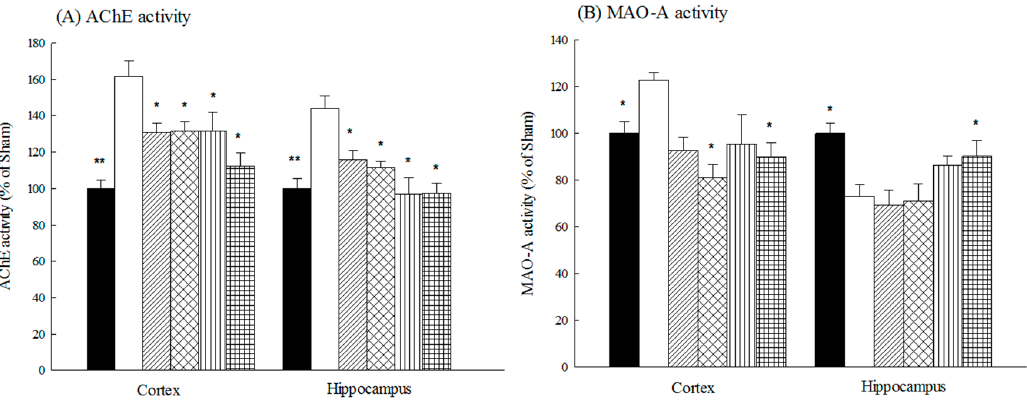
Figure 5. Effects of acteoside or isoacteoside (2.5, 5.0 mg/kg; po) on: ( A ) choline (Ch) levels; ( B ) acetylcholine (Ach) levels; and ( C ) ratio of Ch to Ach in cortex and hippocampus of A β 1-42-infused rats. Acteoside or isoacteoside was continuously administered after A β 1-42 infusion until all rats were sacrificed. Columns indicate mean ± SEM ( n = 6). * p < 0.05, ** p < 0.01, *** p < 0.001 compared with A β 1-42-infused rats.